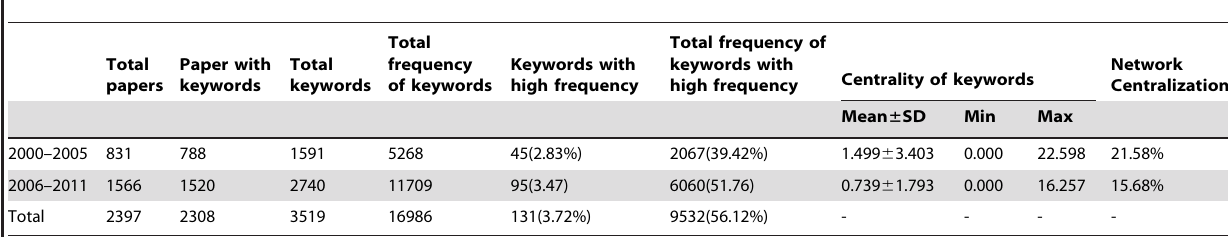
Table 1. Descriptive Statistics for Each Measure about Adherence Research in